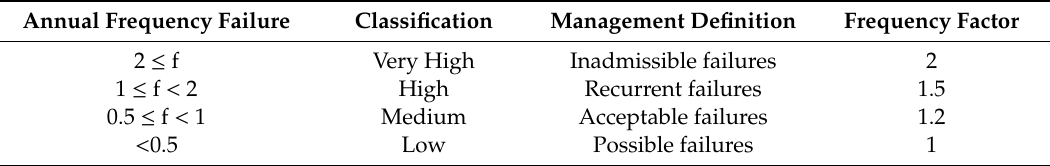
Table 2. Frequency factors used in the power lines